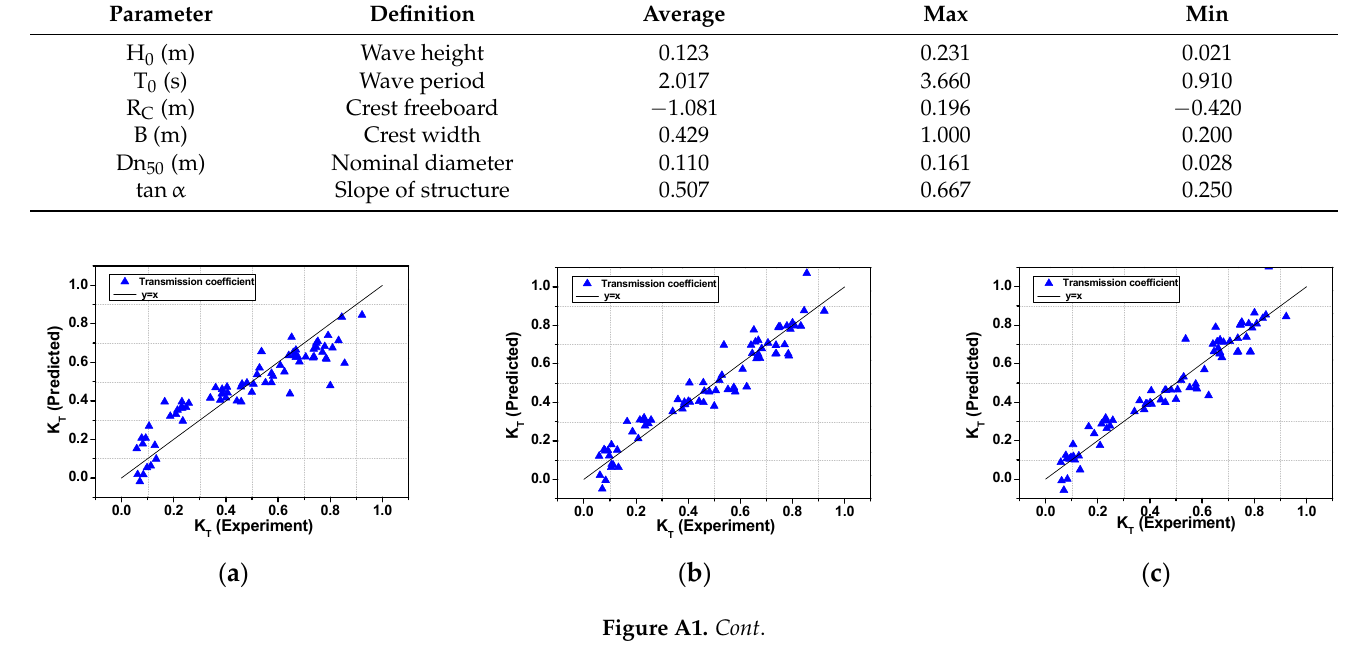
( f ) ( g ) ( h ) ( i ) ( j ) Figure A1. Measured versus predicted values for the various models. ( a ) Linear; ( b ) Ridge; ( c ) Lasso; ( d ) KR; ( e ) GPR; ( f ): SVM; ( g ) RF; ( h ) ANN; ( i ) AdaBoost; ( j ) Gradient boost. References 1.